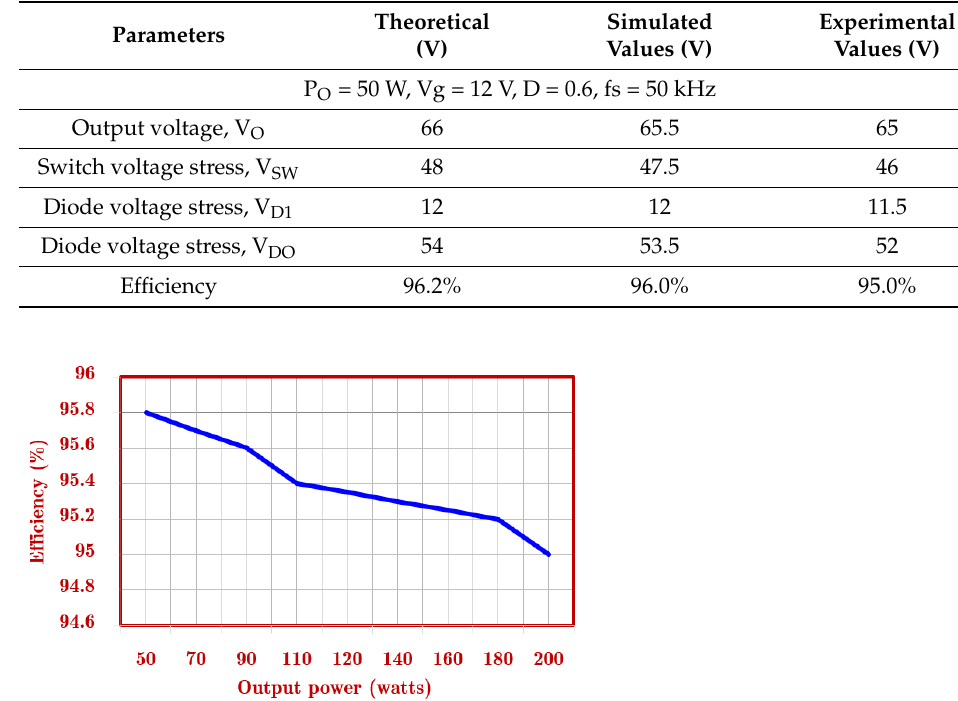
Table 6. Comparison between theoretical, simulation, and experimental results.